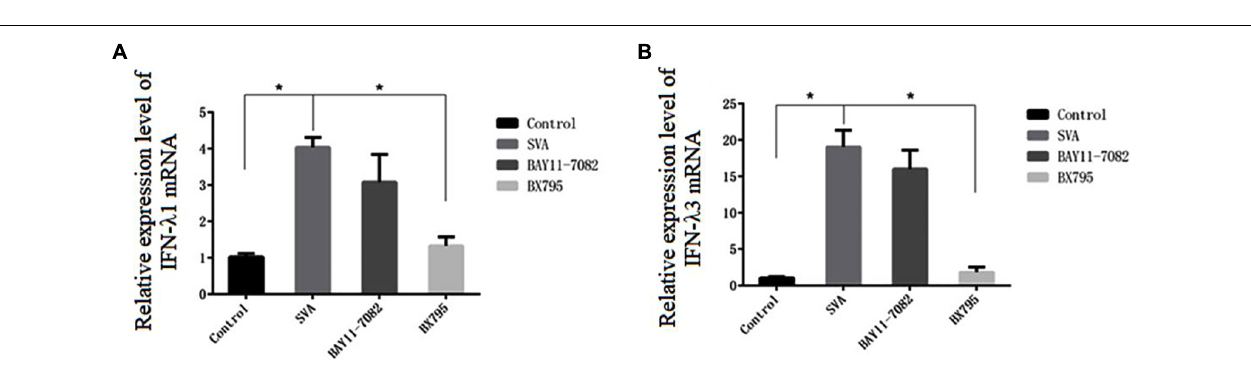
FIGURE 7 | The expression levels of IFN- λ 1 and IFN- λ 3 in PK-15 after SVA infection. The x -axis indicates the time post-infection, and the y -axis represents the fold changes after SVA infection (* P < 0.05). (A) The mRNA expression of IFN- λ 1. (B) The mRNA expression of IFN- λ 3.